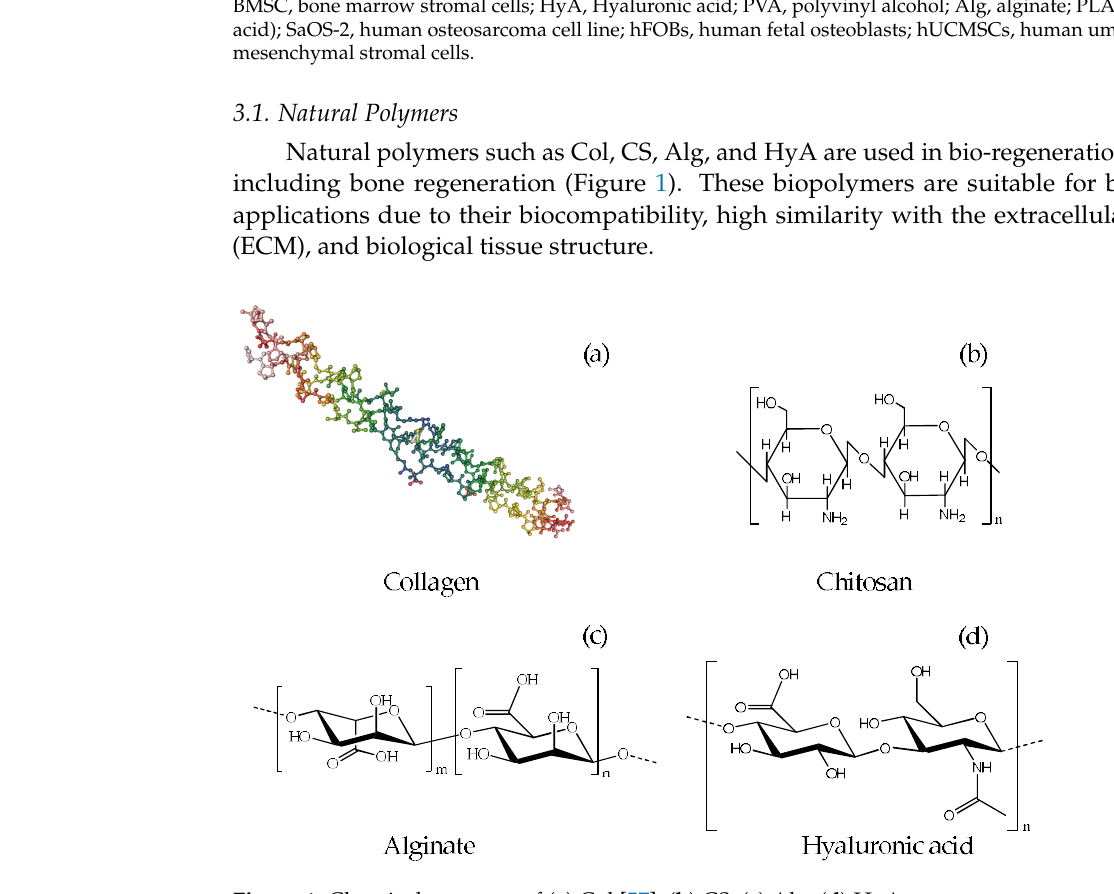
Figure 1. Chemical structure of ( a ) Col [57]; ( b ) CS; ( c ) Alg; ( d )